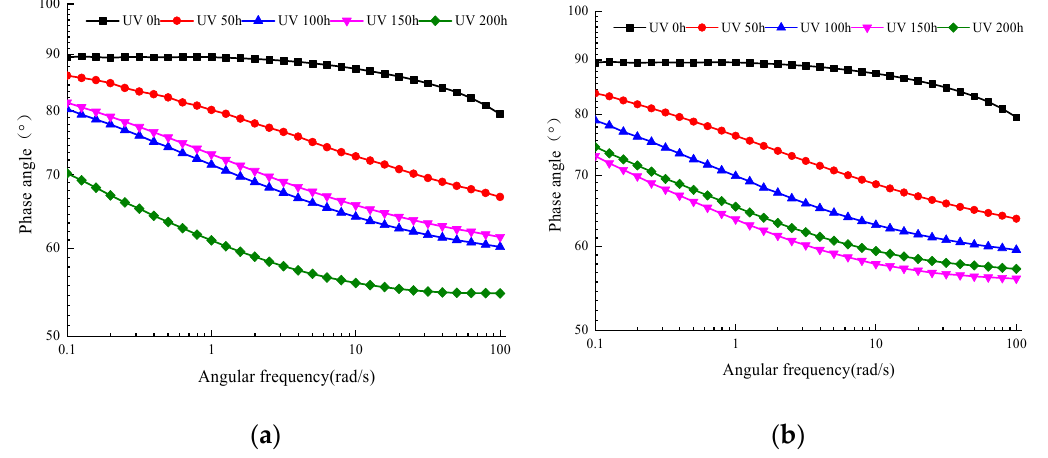
Figure 9. Main curve of phase angle of WMA (70 °C). ( a ) Oxygen isolation conditions. ( b ) Oxygen ‐ containing conditions.